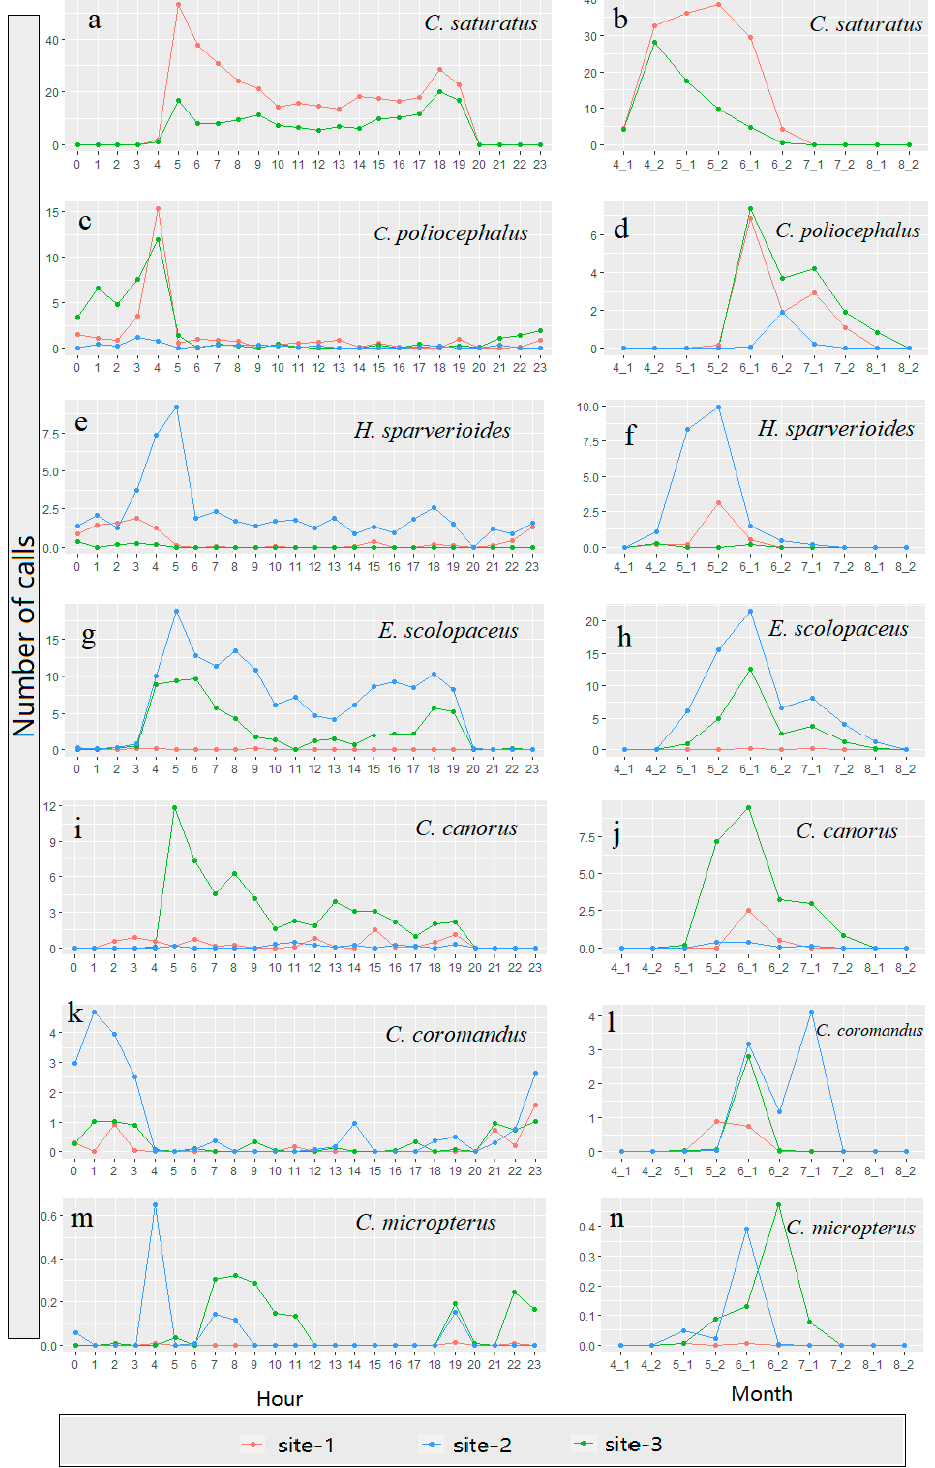
Figure 2. Pattern of diurnal and seasonal vocal activity of Cuculidae species in Yaoluoping National Nature Reserve (China). Different lines indicate patterns of calling activity at three different sites. The diurnal pattern is expressed as the mean number of calls detected per hour at each site on the Y -axis and hours of the day on the X -axis. The seasonal pattern is expressed as the mean number of calls detected per hour at each site on the Y -axis and time of the season every half month on the X -axis.